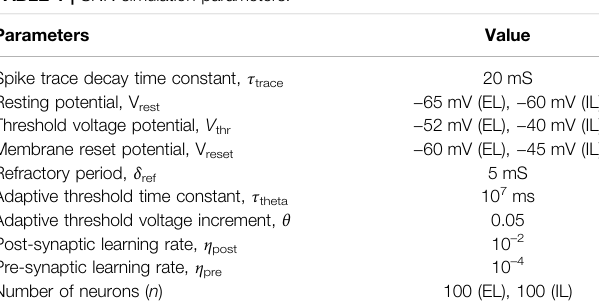
TABLE 1 | SNN simulation parameters.